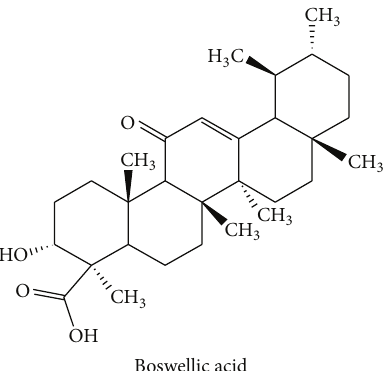
Figure 5: Chemical structure of boswellic